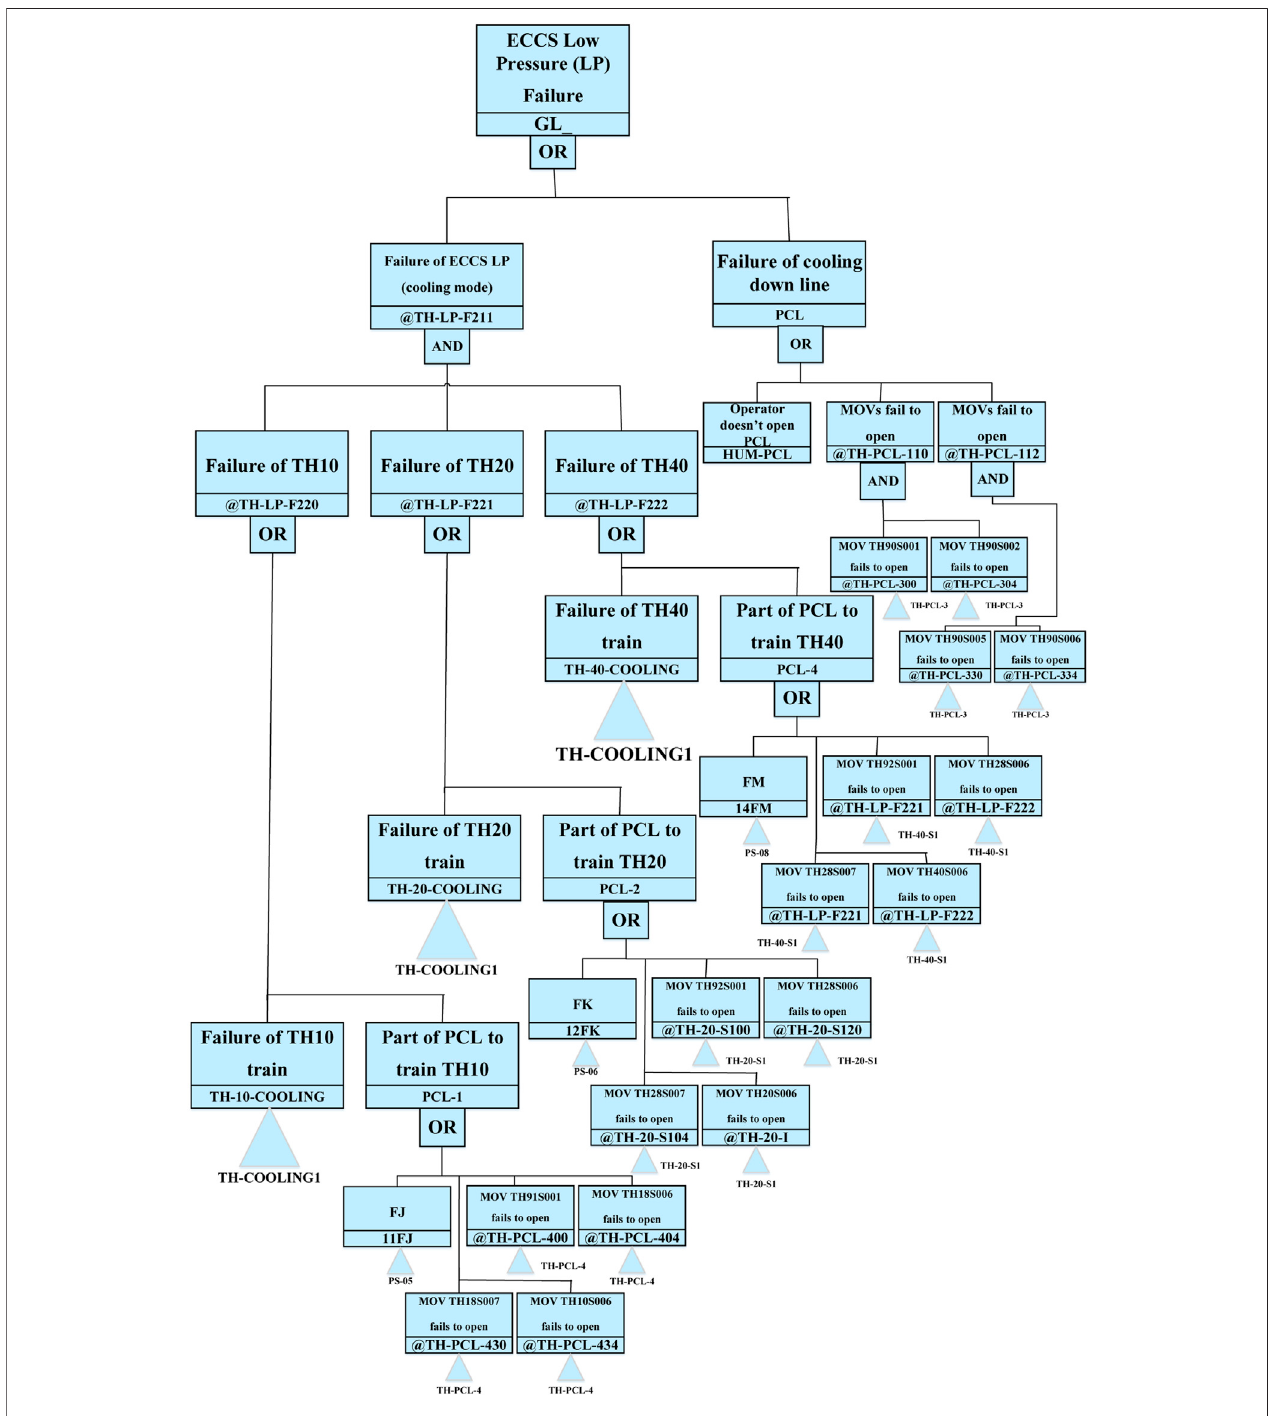
FIGURE 6 | A simpli fi ed FT for the GL function of ECCS system of VVER1000/V446 NPP (AEOI, 2003).